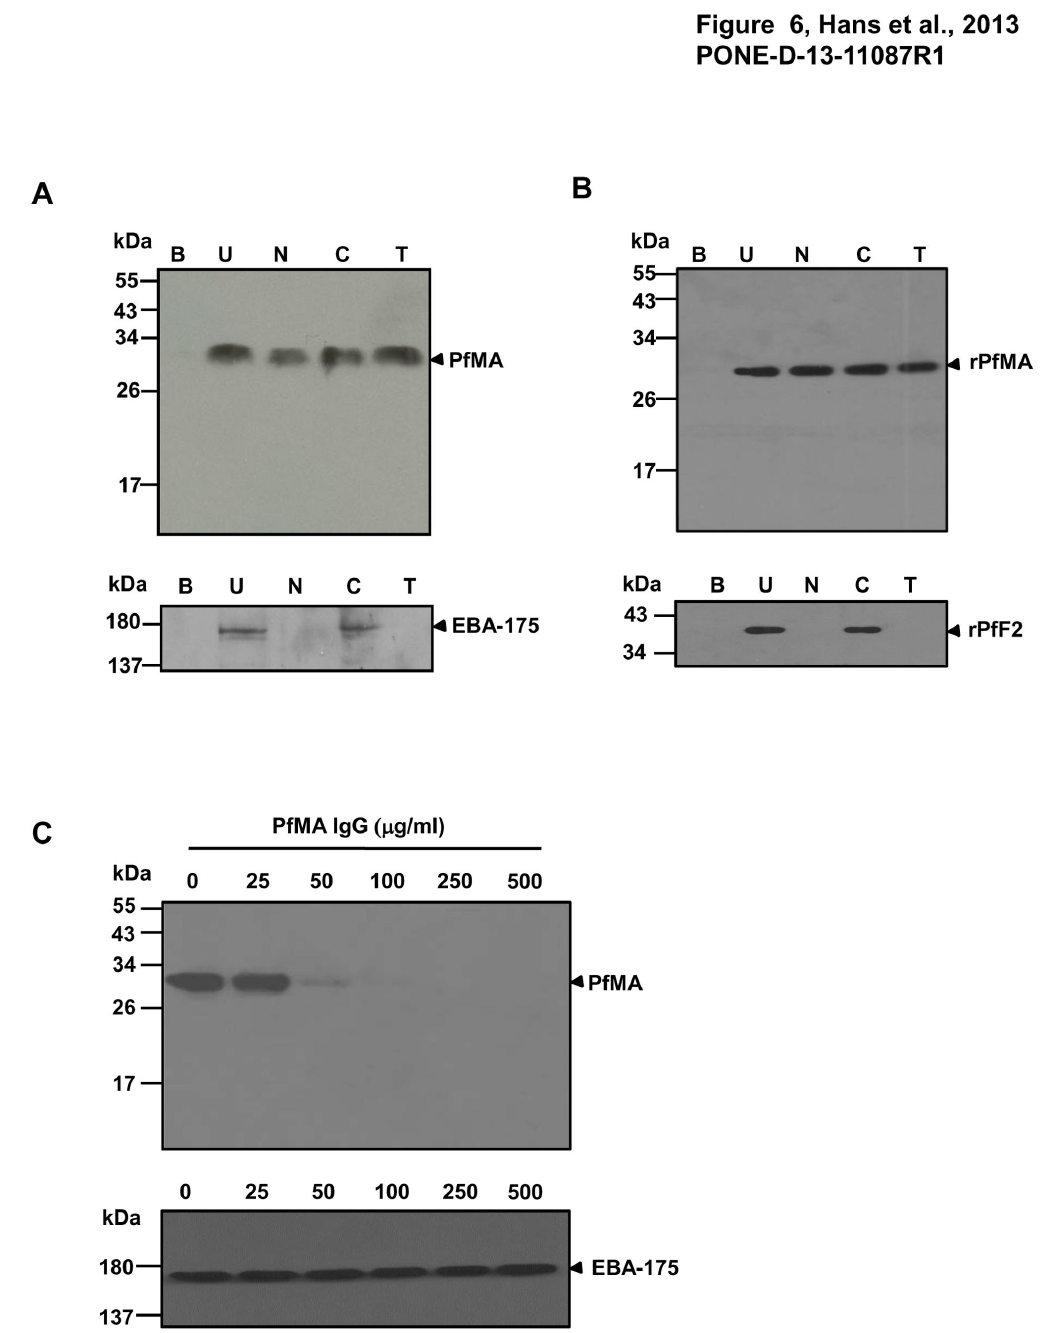
Figure 6. PfMA exhibits erythrocyte binding activity and anti-rPfMA antibodies blocked the erythrocyte binding of native PfMA. ( A ) The erythrocyte binding activity of native PfMA was analyzed with a panel of untreated and different enzymatically treated erythrocytes. The ~32 kDa PfMA protein from parasite culture supernatants bound to untreated (U), neuraminidase (N), chymotrypsin (C) and trypsin (T) treated erythrocytes. Binding of native PfEBA-175 from the same parasite culture supernatants was analyzed as a positive control. ( B ) Recombinant rPfMA exhibited a similar binding specificity with the same set of enzymatically treated erythrocytes. Binding of rPfF2 was analyzed as a positive control. No PfMA protein was detected when the erythrocytes were incubated with an RPMI only control (B). ( C ) Anti-rPfMA antibodies specifically blocked erythrocyte binding of the native PfMA protein. 3D7 culture supernatant was incubated with normal erythrocytes in the presence of purified rabbit anti-PfMA IgG at different concentrations of 0–500 µg/µl. Anti-PfMA IgG had no effect on the binding of the native EBA-175 parasite protein. doi: 10.1371/journal.pone.0074790.g006 PLOS ONE |